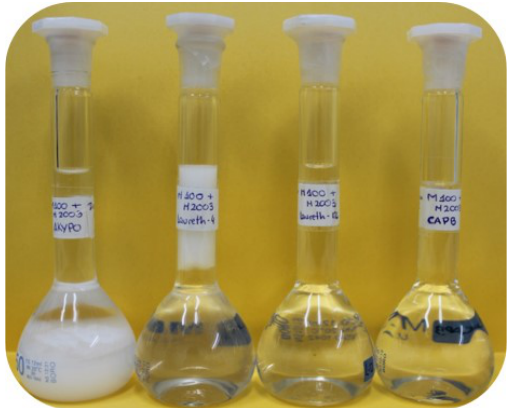
Figure 10. Image showing the aspect of the pseudo-ternary polymer–surfactant mixtures, containing both PDADMAC and Merquat 2003, with the same composition of components as that existing in the model mixture. The mixtures contain the following surfactants (from left to right): AKYPO, LE4, LE12, and CAPB.